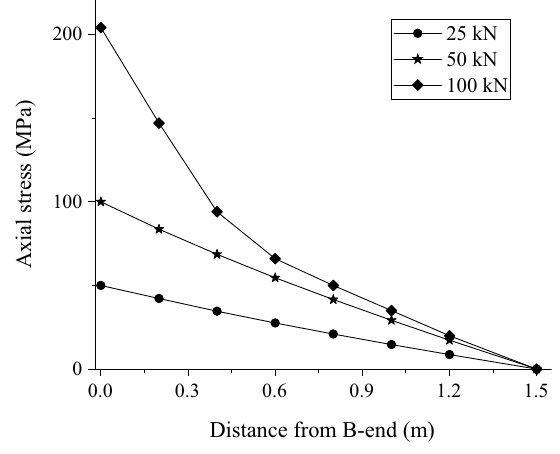
Fig. 16 Axial stress distribution along rockbolt under various pull-out loads (with 1.5 m bond